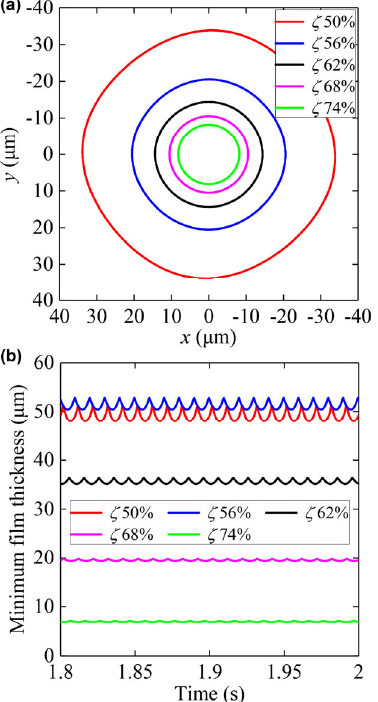
Fig. 5 (a) Journal center orbits and (b) dynamic minimum film thicknesses of a TPJB without static loads for different pivot offsets.